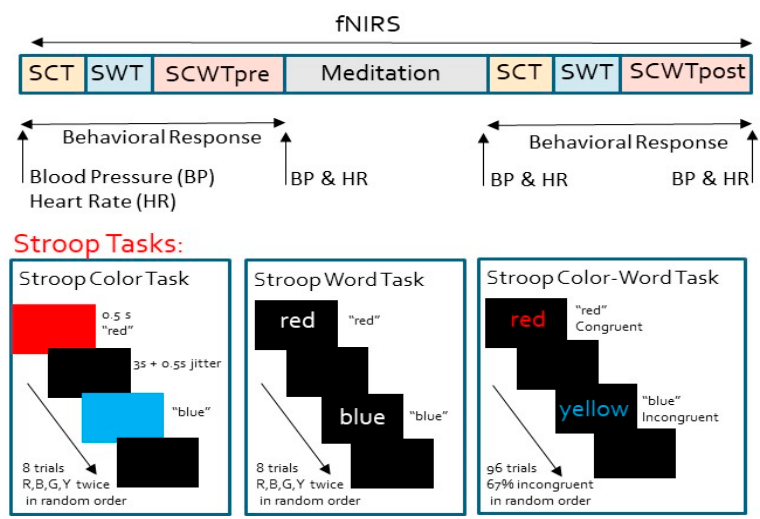
Figure 1. Overall task protocol and procedures.